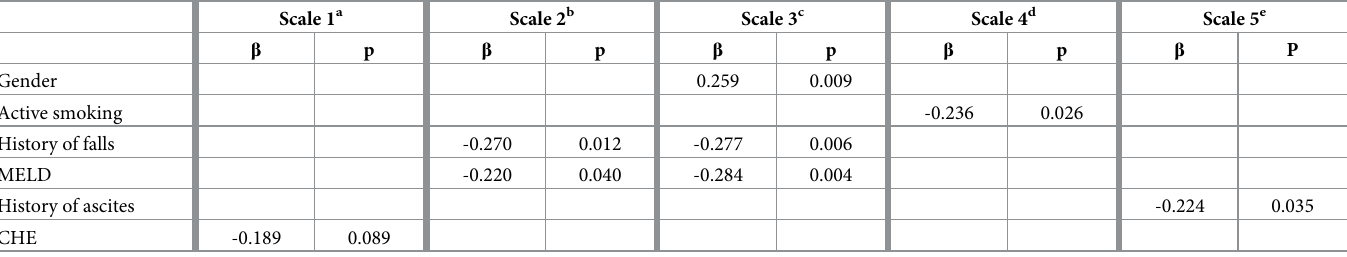
Table 4. Multivariable analyses of risk factors of the HLQ subscales 1–5, which were found significant in univariable analyses.